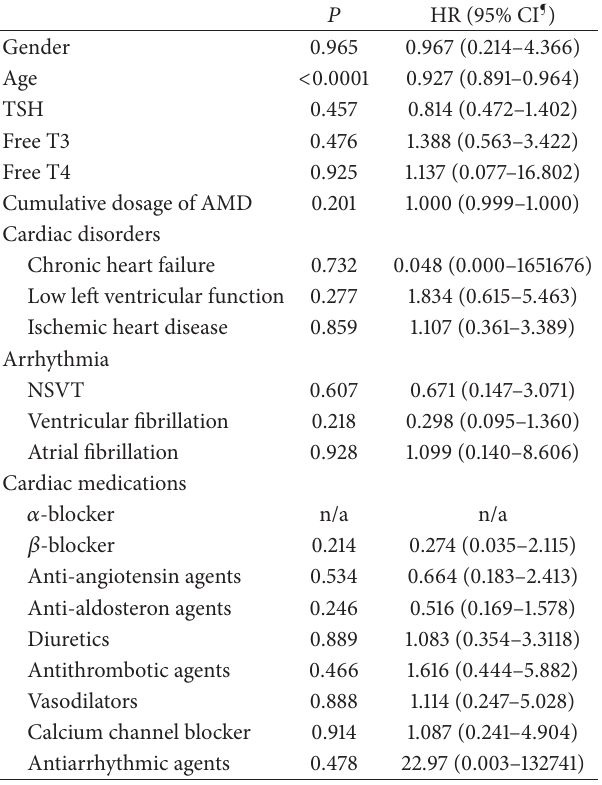
Table 2: Results of univariate Cox proportional hazards regression